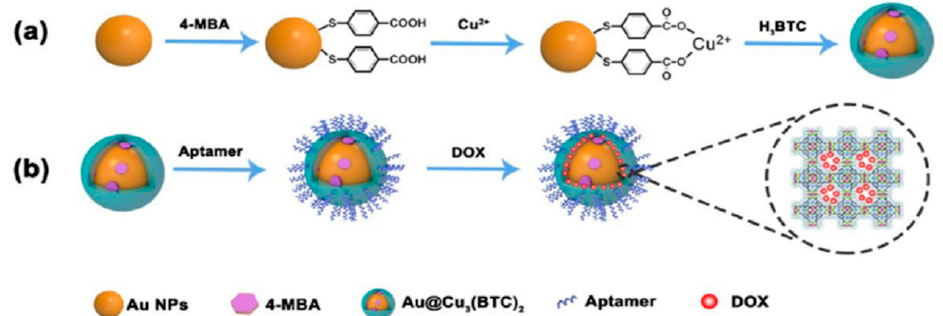
Figure 20. Diagram of preparation of Au@Cu 3 (BTC) 2 NPs ( a ), and modification of Au@Cu 3 (BTC) 2 NPs ( b ). (Reprinted with permission from RSC, 2019 [92]).